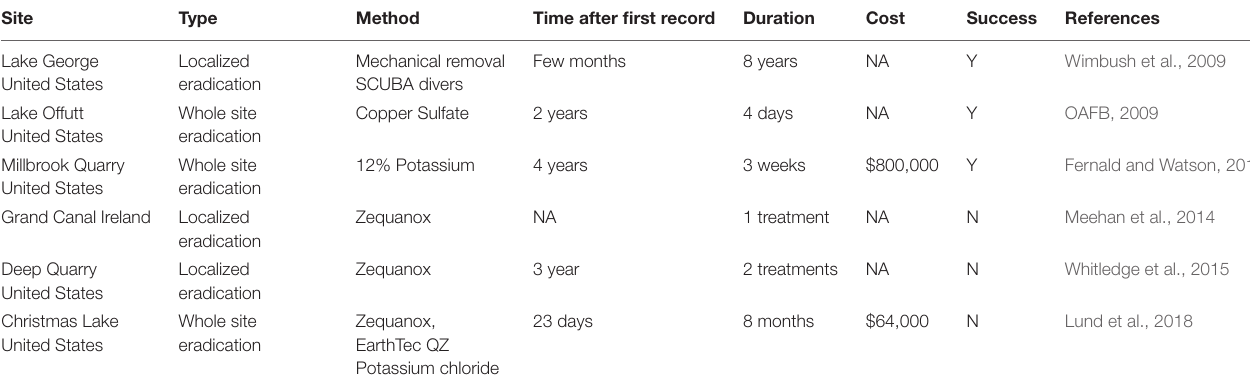
TABLE 1 | Examples of eradication programs of zebra